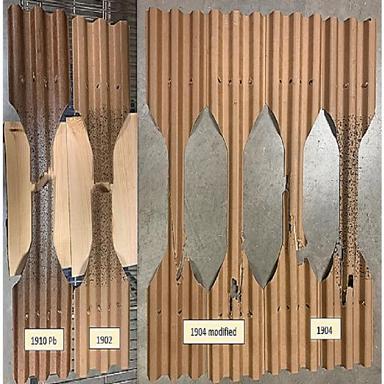
The failure of various corrugated panels under longitudinal tensile loading.